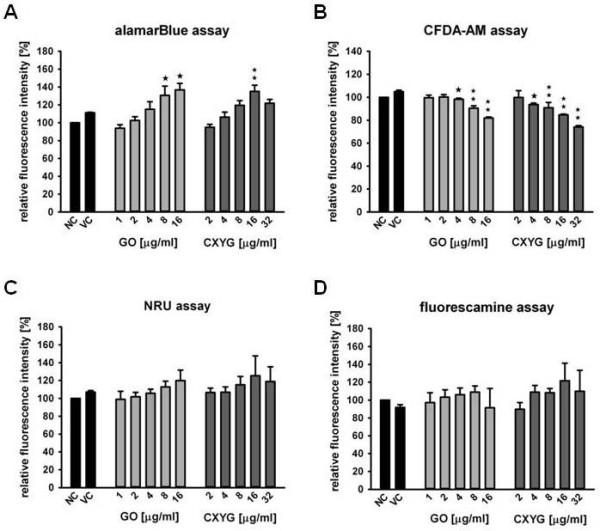
Effect of GO and CXYG on Hep G2 cell viability. Hep G2 cells were exposed to increasing concentrations of GO (grey bars) or CXYG (dark grey bars) for 72 h. GO and CXYG suspensions were prepared by diluting aqueous stock suspensions in medium supplemented with 10% FBS. The vehicle control (VC) consisted of 10% (v/v) Milli-Q water in medium. Cells incubated with only medium served as negative control (NC) (black bars). Cytotoxicity of GO and CXYG was assessed by means of the alamarBlue assay (A), CFDA-AM assay (B), NRU assay (C) and the fluorescamine assay (D). Bars represent the mean and standard error of the mean (SEM) of at least three independent repetitions. Statistically significant differences with respect to the vehicle control (one-way rmANOVA, Dunnett´s Post-hoc test) are indicated as followed: ☆ p < 0.05, ☆☆ p < 0.01.